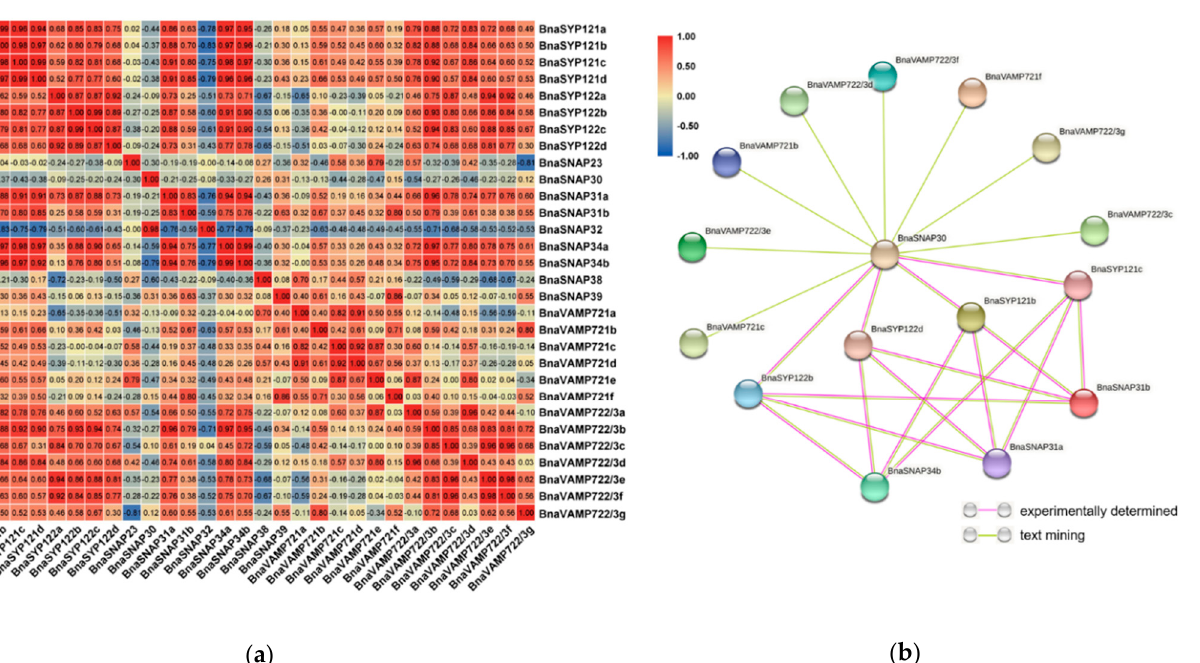
Figure 8. Correlations between the gene expression patterns of BnsSYP121/2s, BnaSNAPs, and BnaVAMP721/2/3s ( a ) and putative interaction networks among these proteins ( b ).